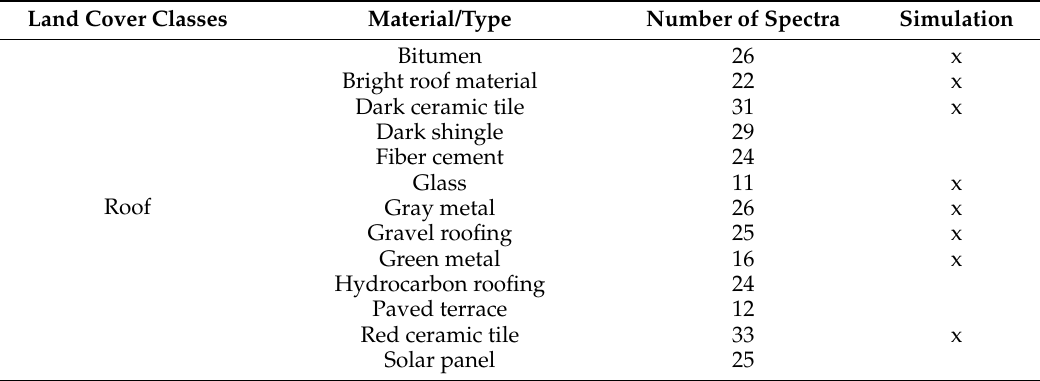
Table 1. Brussels spectral library organized per land cover class, including an indication of library size per urban material or vegetation type and whether or not the material or type has been used in the creation of the simulated image (all included materials are indicated using the symbol